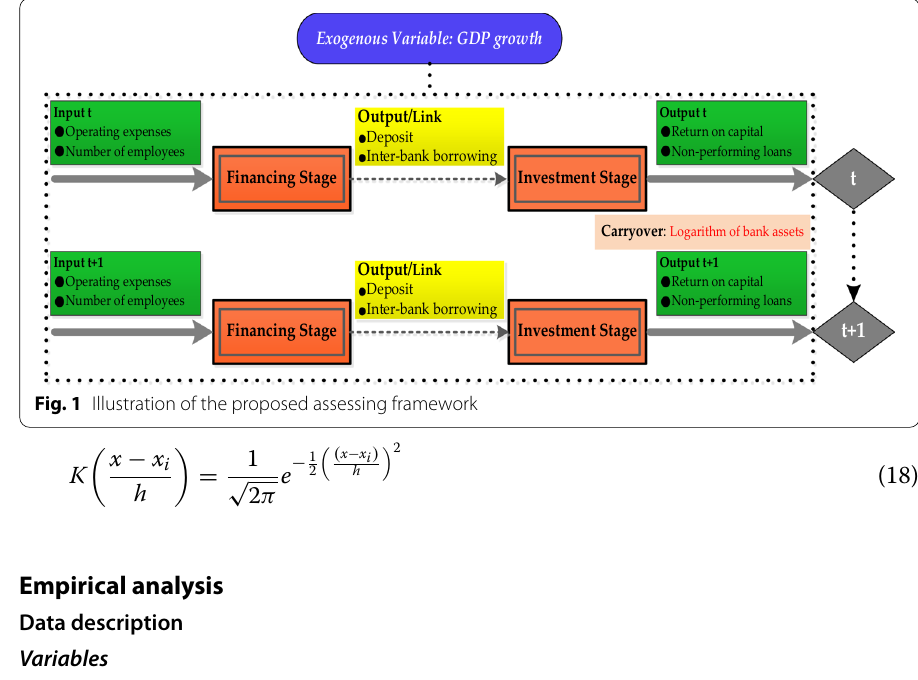
Fig. 1 Illustration of the proposed assessing